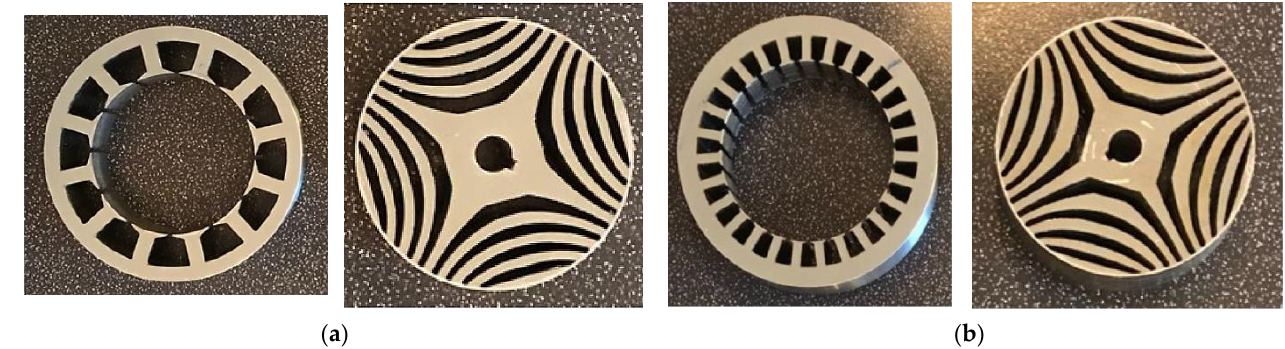
Figure 2. Manufactured optimal stator/rotor topologies from [10]. ( a ) 12/4 concentrated winding and ( b ) the 27/4 distributed winding.